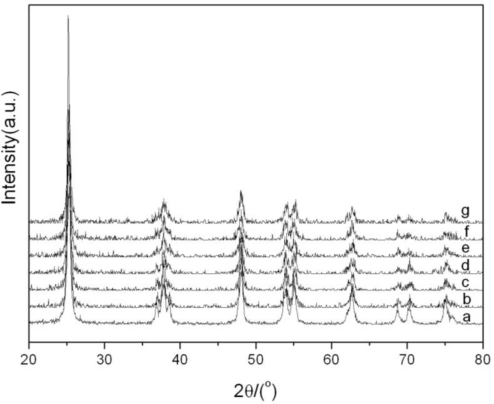
XRD spectra of photocatalysts: (a) TiO2; (b) 0.1%Fe3O4/SiO2/TiO2; (c) 0.25%Fe3O4/SiO2/TiO2; (d) 0.5%Fe3O4/SiO2/TiO2; (e) 1%Fe3O4/SiO2/TiO2; (f) 5%Fe3O4/SiO2/TiO2; (g) 10%Fe3O4/SiO2/TiO2.